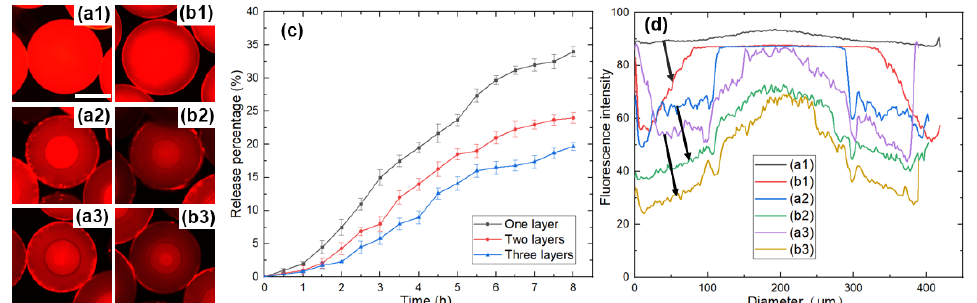
Figure 8. ( a ) Fluorescence images of microspheres with different number of layers: ( a1 ) One layer, ( a2 ) Two layers, ( a3 ) Three layers. ( b ) Fluorescence images of microspheres with different number of layers after drug release: ( b1 ) One layer, ( b2 ) Two layers, ( b3 ) Three layers. The scale bar is 200 µm. ( c ) Drug release profiles of microspheres. ( d ) Corresponding fluorescence intensity along the diameter of the microspheres before and after drug release. The letters correspond to the microspheres in Figure 8a,b.